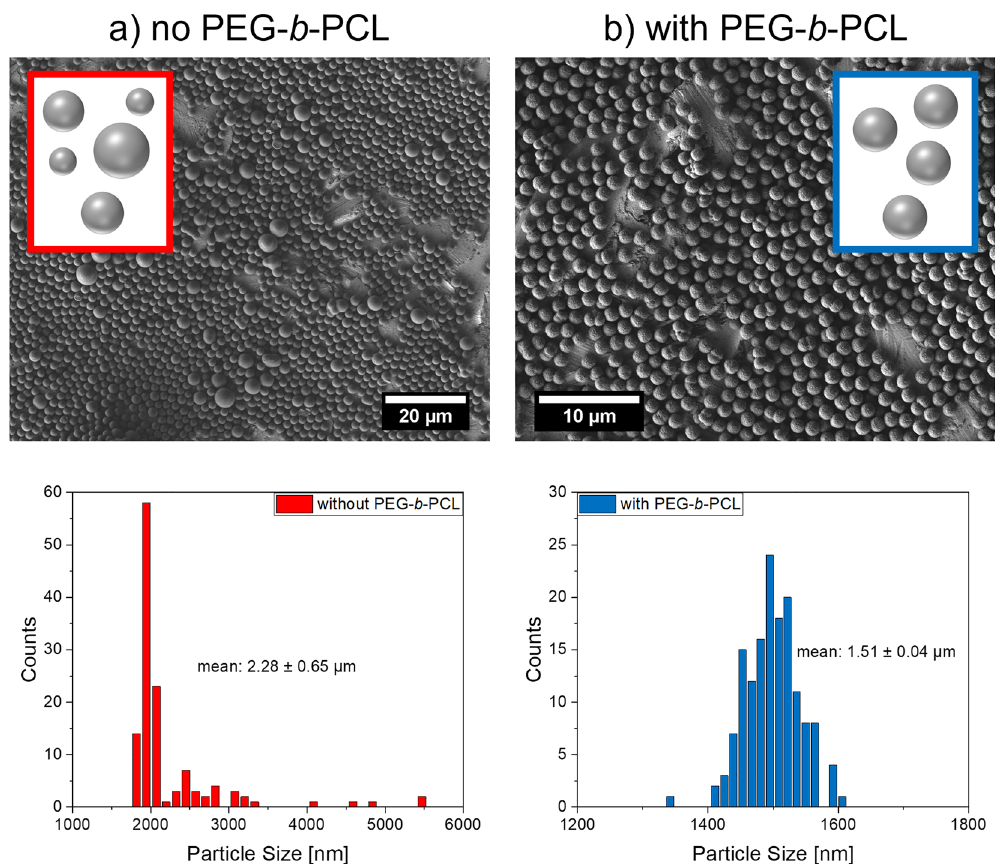
Figure 2. SEM images and particle size distributions of the different PS microbeads prepared: ( a ) without addition of PEG- b -PCL (toluene added without PEG- b -PCL; synthesis with 500 mg AIBN, no crosslinker) and ( b ) with addition of 36.6 mg PEG- b -PCL in toluene (synthesis with 100 mg AIBN, crosslinked with 200 µL DVB). Conditions used for the preparation of both bead types: 75 °C, 70 rpm stirring speed, 24 h reaction